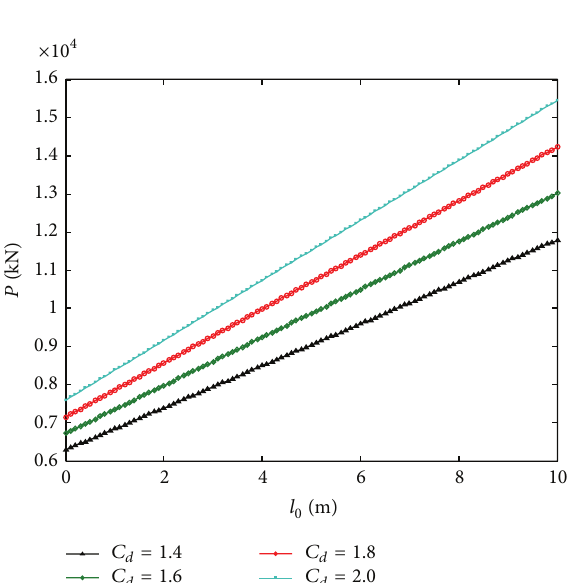
Figure 12: The relation between 𝑃 and 𝑙 0 , 𝐶 𝑑 .